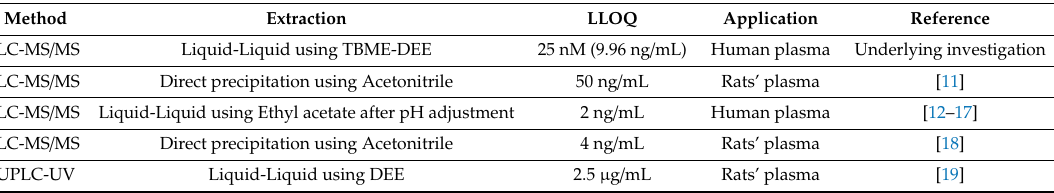
Figure 4. Daughter ions mass spectra in positive ESI ion detection mode with the proposed fragments showing m / z at 116.02 for alogliptin. Table 1. Comparison between previously reported methods for omariglitpin (OTN) extraction and determination in plasma either rats’ plasma or human